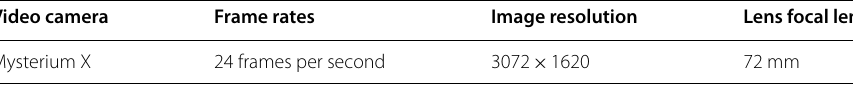
Table 1 Camera specifications